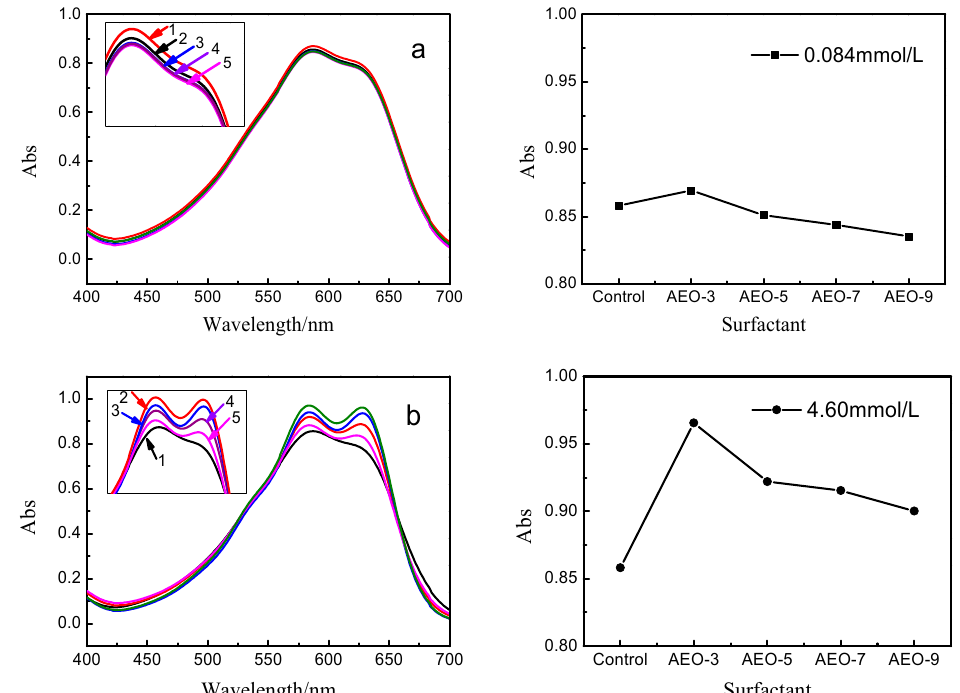
Figure 8. Absorption spectra of reactive blue 19 (0.16 mmol/L) in the presence of alkyl alcohol polyoxyethylene ether with different poly-EO chains. ( a ) [concentration = 0.084 mmol/L]: (1) AEO-3, (2) control, (3) AEO-5, (4) AEO-7, (5) AEO-9; ( b ) [concentration = 4.60 mmol/L]: (1) control, (2) AEO-3, (3) AEO-5, (4) AEO-7, (5) AEO-9.